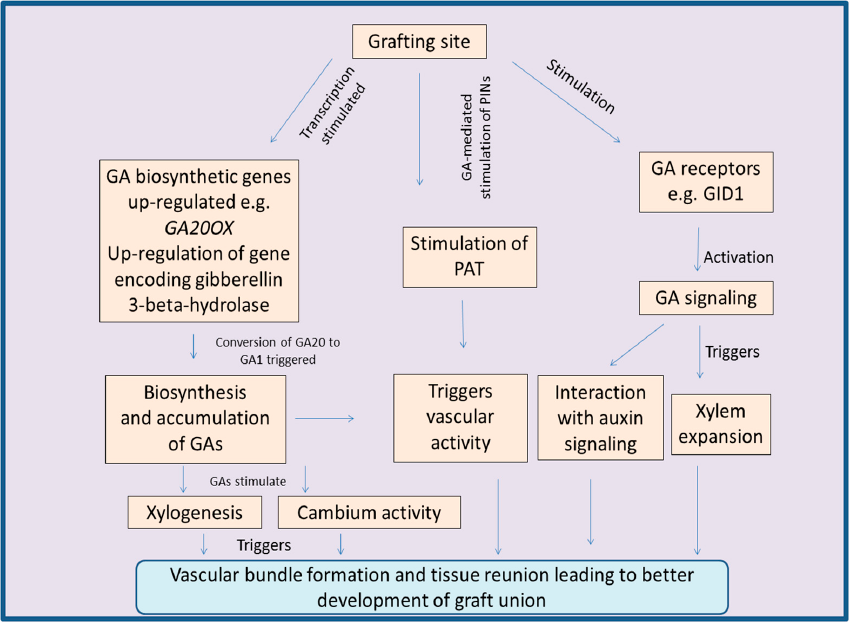
Figure 3. Diagram explaining how gibberellins regulate the process of plant grafting. It is a conclusion diagram, based on the various studies mentioned in the section related to gibberellins. Gibberellins (GA); graft union (GU); PIN-FORMED auxin transport proteins (PINs); polar auxin transport (PAT); GIBBERELLIN INSENSITIVE DWARF1 (GID1); Gibberellin 20-oxidase ( GA20OX